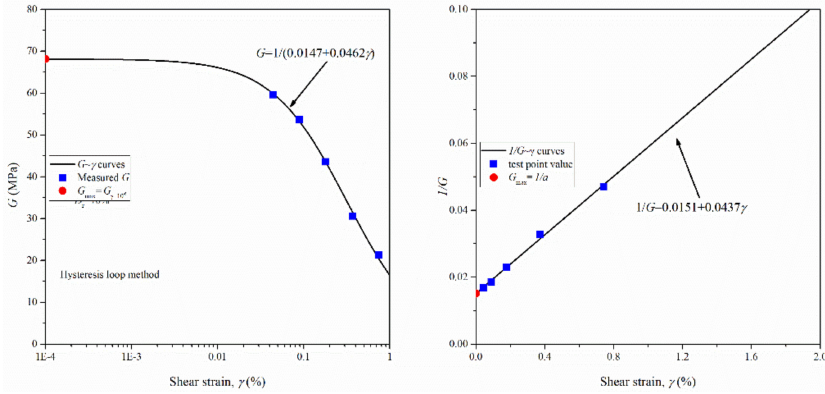
Figure 9. Schematic representation of G max = G γ =10 − 6 and G max = 1/a. A systematic comparison between two estimation methods of G max is carried out, and some discrepancies are observed in both the G max and the corresponding G / G max